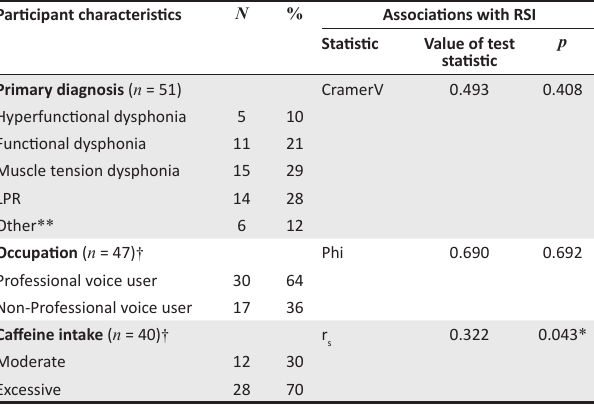
TABLE 2: Associations of reflux symptom index with demographics of participants. Participant characteristics